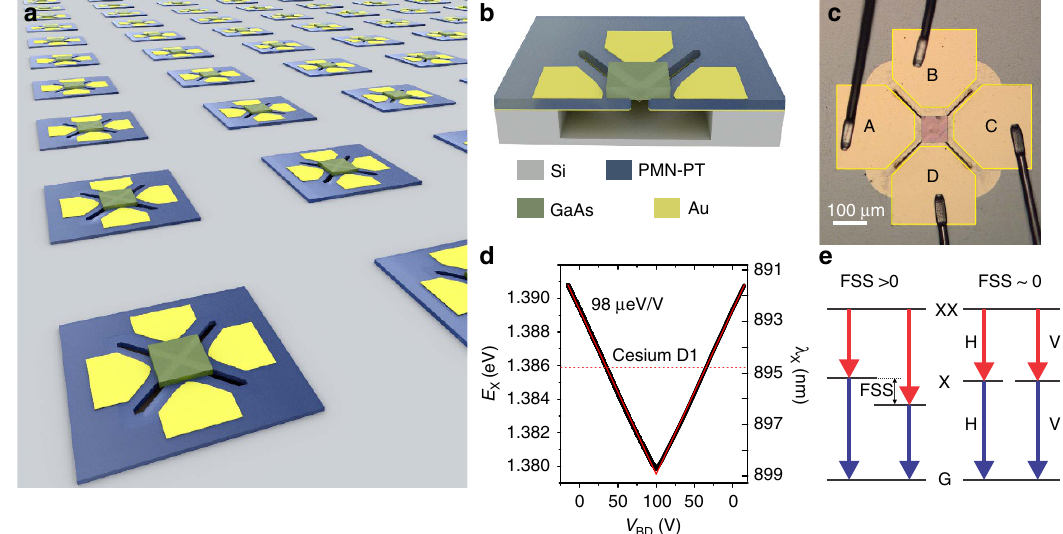
Figure 1 | Wavelength-tunable polarization-entangled photon sources integrated on silicon. ( a ) MEMS devices for anisotropic strain engineering of III–V QD-based quantum light sources. Owing to its small footprint and the compatibility with mature semiconductor technologies, large scale on-chip integration is feasible. ( b ) Schematic of the cross section of a single device. Focused ion beam (FIB) cut is used to define trenches on the PMN-PT thin film, and then wet-chemical undercut is used to form four suspended actuation legs. A thin GaAs nanomembrane containing In(Ga)As QDs is transferred onto the suspended region between the four legs. ( c ) Micrograph showing the zoom-in of a completed device. Electrical contacts are made on the four legs A–D. The centre region is a bonded QD-containing nanomembrane. ( d ) Performance of a typical device. The exciton wavelength of a single QD is recorded when the voltage on legs B&D is scanned. The actuation legs contract under positive voltages, leading to the tensile stresses on the nanomembrane and to the red shift of the QD emission. The red solid lines show the linear fit. The dashed line indicates the caesium D1 absorption line. ( e ) Illustration of the FSS in a QD. Polarization-entangled photons are emitted from the XX cascade emission only when the FSS is tuned to near